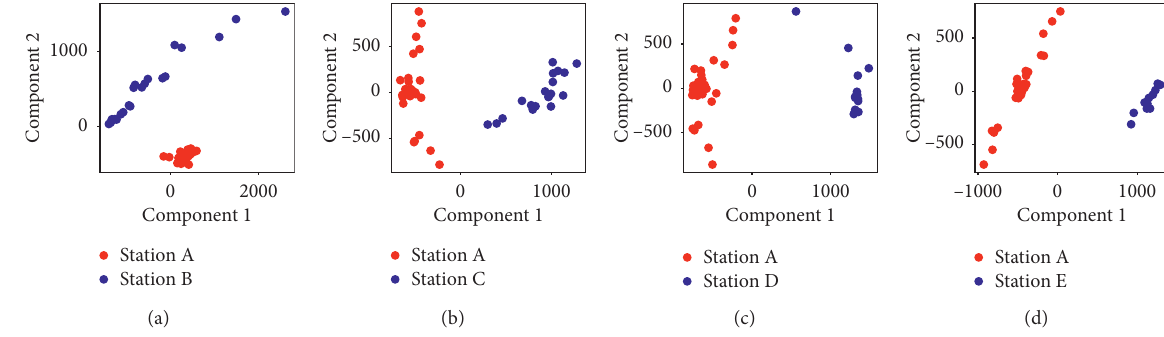
Figure 8: MRF feature vectors between Station A and (a) Station B, (b) Station C, (c) Station D, and (d) Station